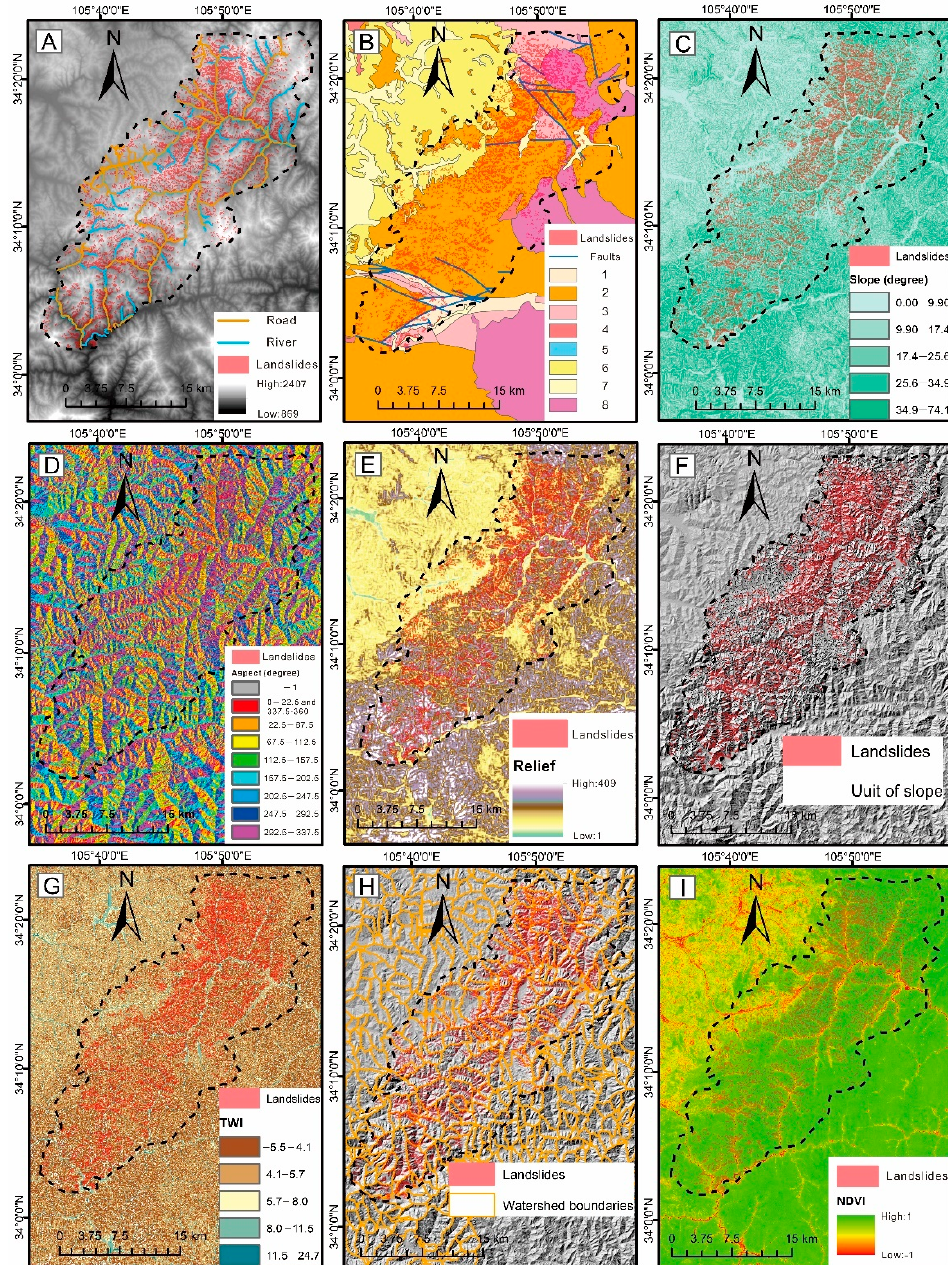
Figure 4. Shows part of the landslide ‐ influencing factors used in this study. ( A ) Digital Elevation Mode (DEM); ( B ) Lithology and fault, 1. Carboniferous glutenite, 2. Middle Devonian marl, slate, 3. Late Devonian slate and sandstone, 4. Paleogene sandstone, 5. Jurassic sandstone and limestone, 6. Neogene mudstone, 7. Quaternary sediments, 8. ( E ) Local relief; ( F ) Unit of slope; ( G ) TWI; ( H ) Watershed; ( I ) Yanshanian granite; ( C ) Slope; ( D ) Slope aspect; ( E ) Local relief; ( F ) Unit of slope; ( G ) TWI; ( H ) Watershed; ( I ) NDVI.